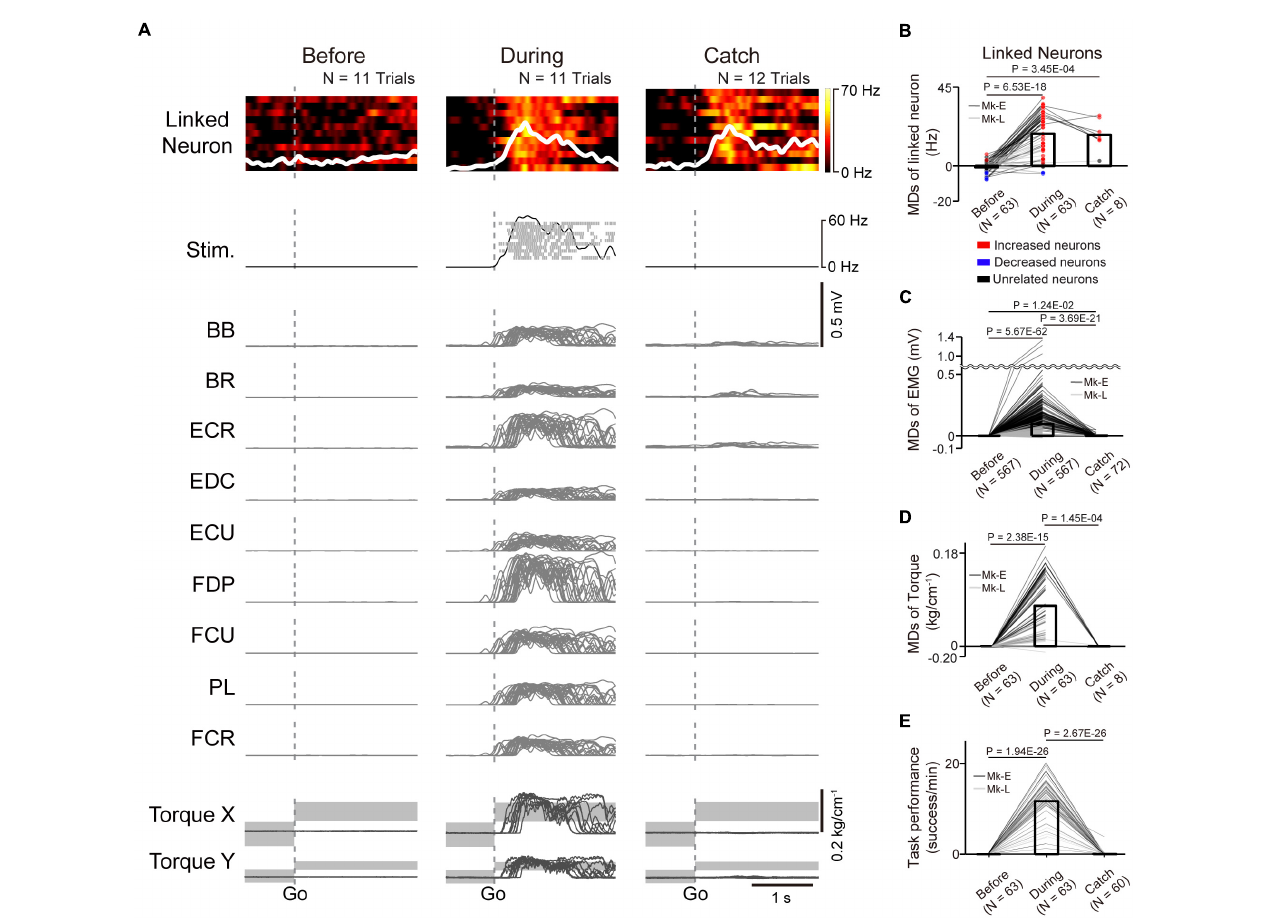
FIGURE4 Task-related modulation of linked neurons, EMG, and torque. (A) Examples of the firing rate in individual trials (heatmap) and the average firing rate (white trace) of a linked neuron (1st row), spinal stimulation (2nd row), EMG of the forelimb (3rd–11th rows), and wrist torque (12th and 13th rows) before (left panel) and during the corticospinal interface (center panel) and catch trials (right panel). Plots are aligned to the timing of target appearance, indicated by the vertical dotted lines. The gray-shaded rectangles in the bottom traces represent the target range of the required torque for a successful trial. MDs of the firing rates of linked neurons (B) , EMG (C) , and wrist torque (D) before (left bar) and during the corticospinal interface (center bar) and catch trials (right bar) [ N = 63 sessions before and during corticospinal interface, 8 sessions during catch trials (Monkey E, N = 40 sessions before and during corticospinal interface, 7 sessions during catch trials; Monkey L, N = 23 sessions before and during corticospinal interface, 1 session during catch trials)]. Bars indicate mean values. Black horizontal lines represent significant differences ( P < 1.67 × 10 − 2 by paired t -test with Bonferroni’s correction). Colors of the circles represent the neuron types sorted in each condition (i.e., before and during corticospinal interface and catch trials). Sessions with at least nine trials in each condition were included in the analysis. (E) Task performance before and during the corticospinal interface trials and during the catch trials [ N = 63 sessions before and during corticospinal interface, 60 sessions during catch trials (Monkey E, N = 40 sessions before and during corticospinal interface, 38 sessions during catch trials; Monkey L, N = 23 sessions before and during corticospinal interface, 22 sessions during catch trials)]. Bars indicate mean values. Black horizontal lines represent significant differences ( P < 1.67 × 10 − 2 by paired t -test with Bonferroni’s correction for post hoc multiple comparisons). Sessions with at least one trial in each condition were included in the